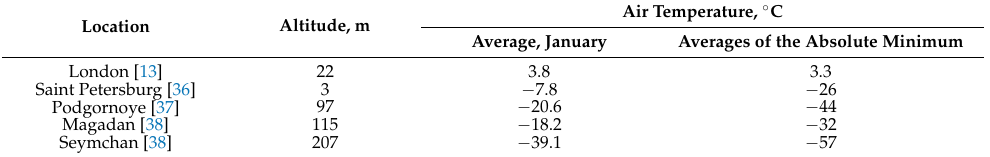
Table 4. Air temperature in geographical locations where the cold hardiness of Aglais urticae was studied. Location Altitude, m